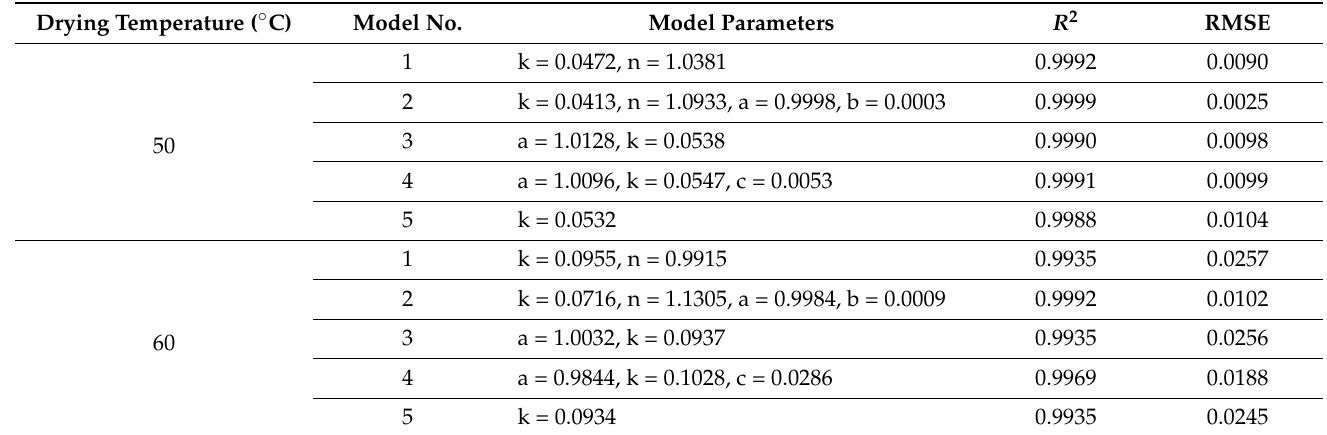
Table 3. Mathematical drying model evaluation for linden leaves samples subject to IRD.